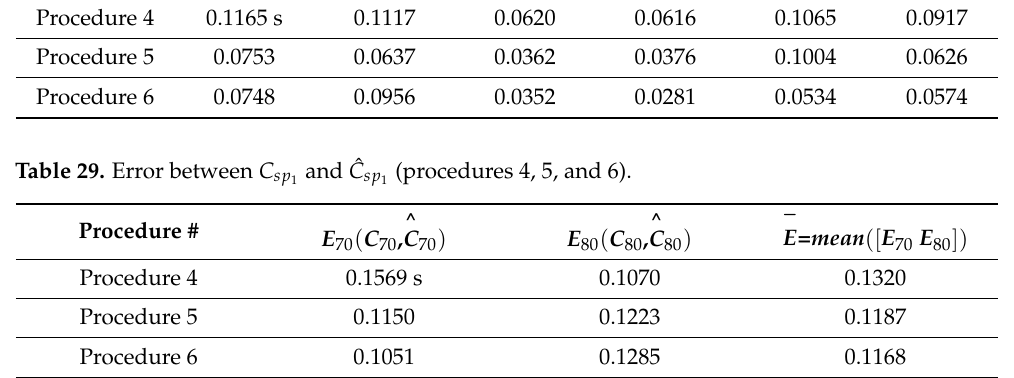
Table 28. Error between C sp